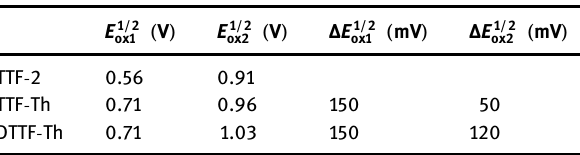
Table 1: Oxidation potentials and migration of TTF - 2, TTF - Th, and DTTF -